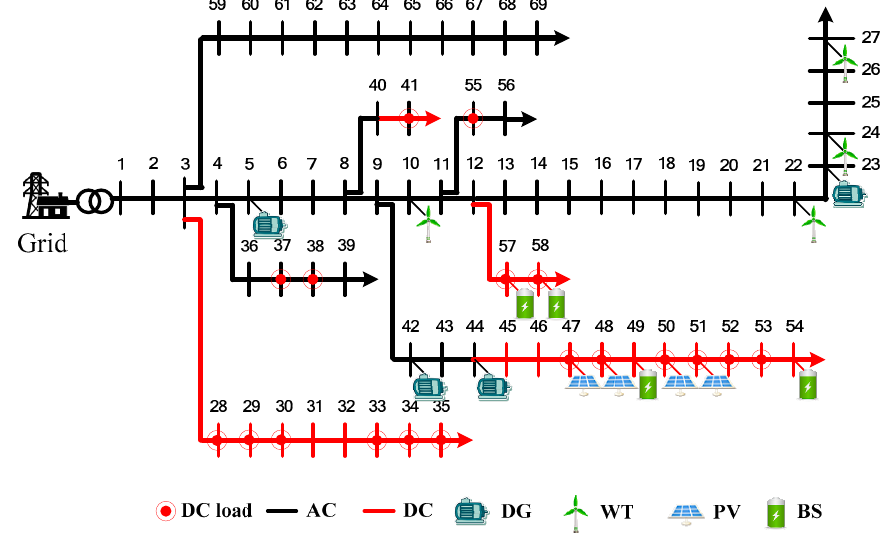
Figure 12. Placement of DERs in the MG in Case Study II.